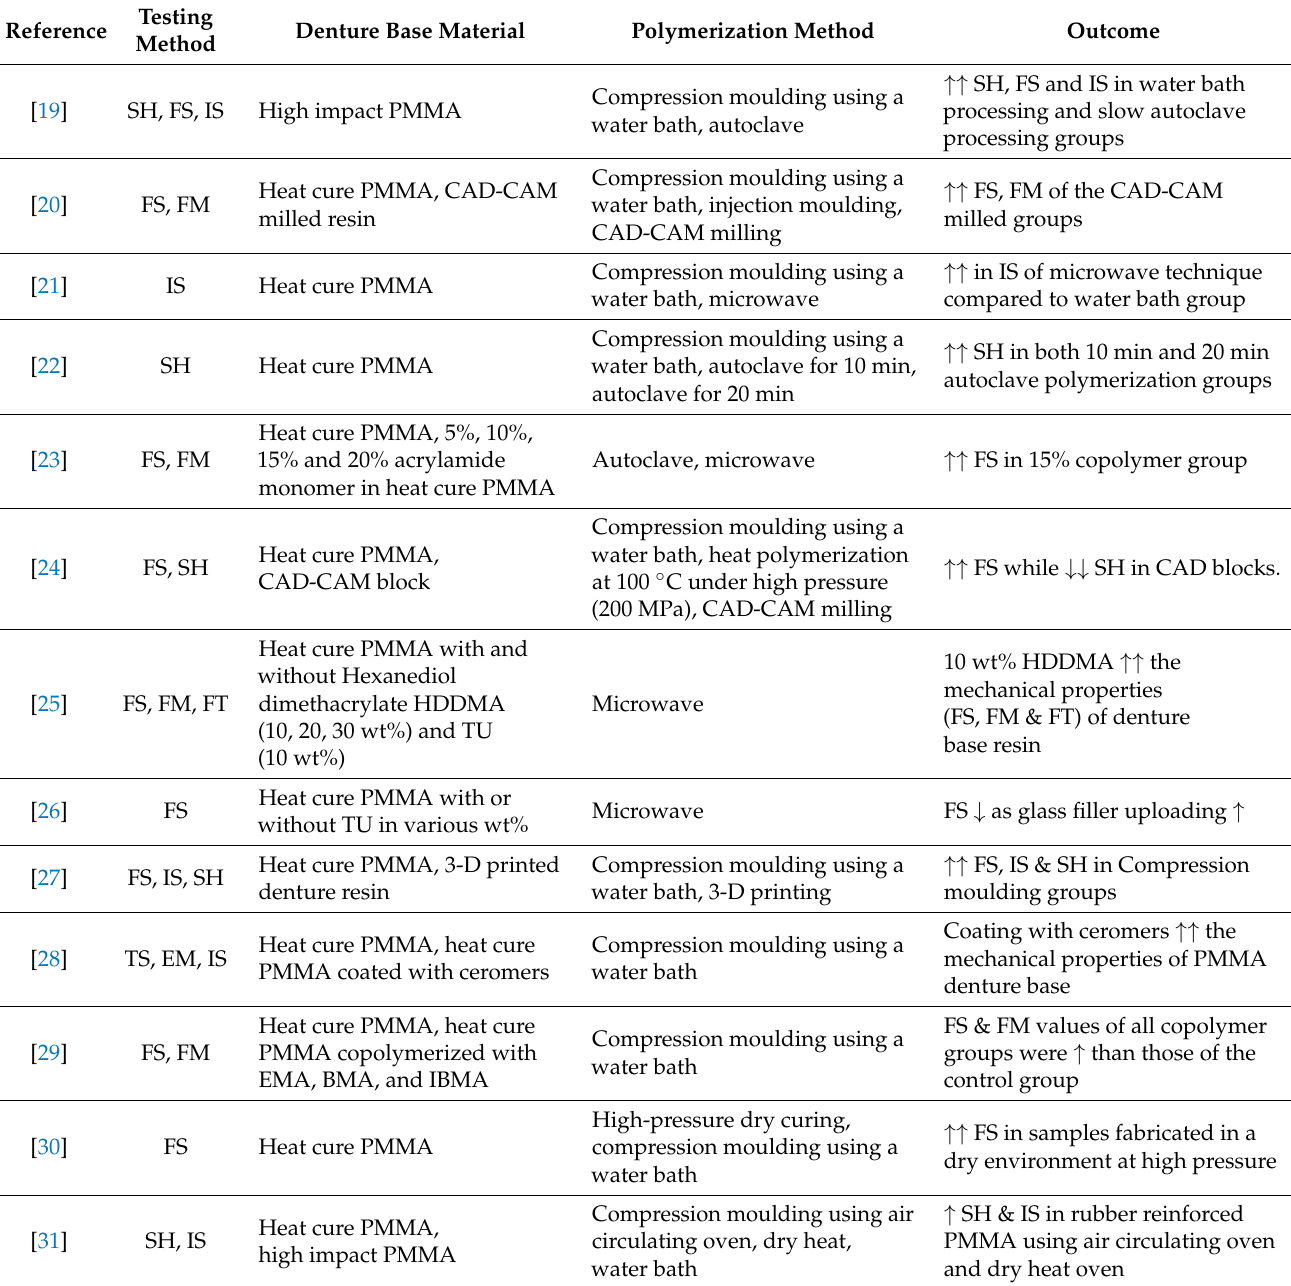
Table 3. Included papers with the type of denture base polymer, polymerization method and their corresponding